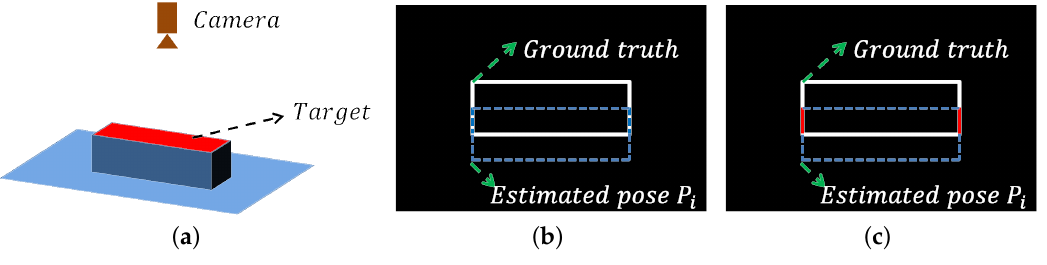
Figure 10. An example of boundary verification considering curves. ( a ) the cuboid target is on the plane and the camera is above them; ( b ) the white pixels are B scene and also present the ground truth of the object. All of the white pixels belong to the same curve. An estimated pose P i is presented by the blue dot line ( B model ( P i ) ); ( c ) since only a small part of the curve (red pixels) matches the B model ( P i ) , this curve is invalid for P i